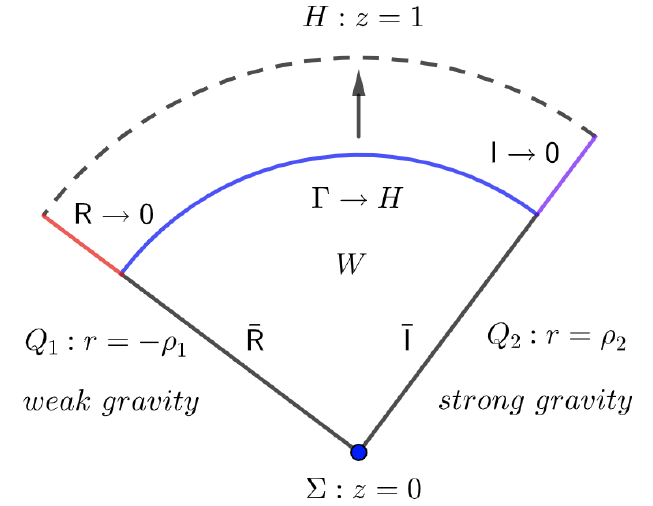
Figure 2 . The geometry of wedge holography without DGP terms and its interpretation in black hole information paradox. W is the bulk wedge space, Q 1 is the weak-gravity “bath” brane and Q 2 is the strong-gravity brane, Σ is the defect on the corner of the wedge, H denotes the horizon in bulk. According to [50], since both branes are gravitating, one should adjust both the radiation region R (red line) and the island region I (purple line) to minimize the entanglement entropy in the island phase. Remarkably, the corresponding RT surface Γ (blue line) coincides with the horizon H (black dotted line). As a result, the potential island and radiation regions I and R of figure 1 disappear. Note that the island region envelops the black-hole horizon on the brane Q 2 , and only the region outside the horizon